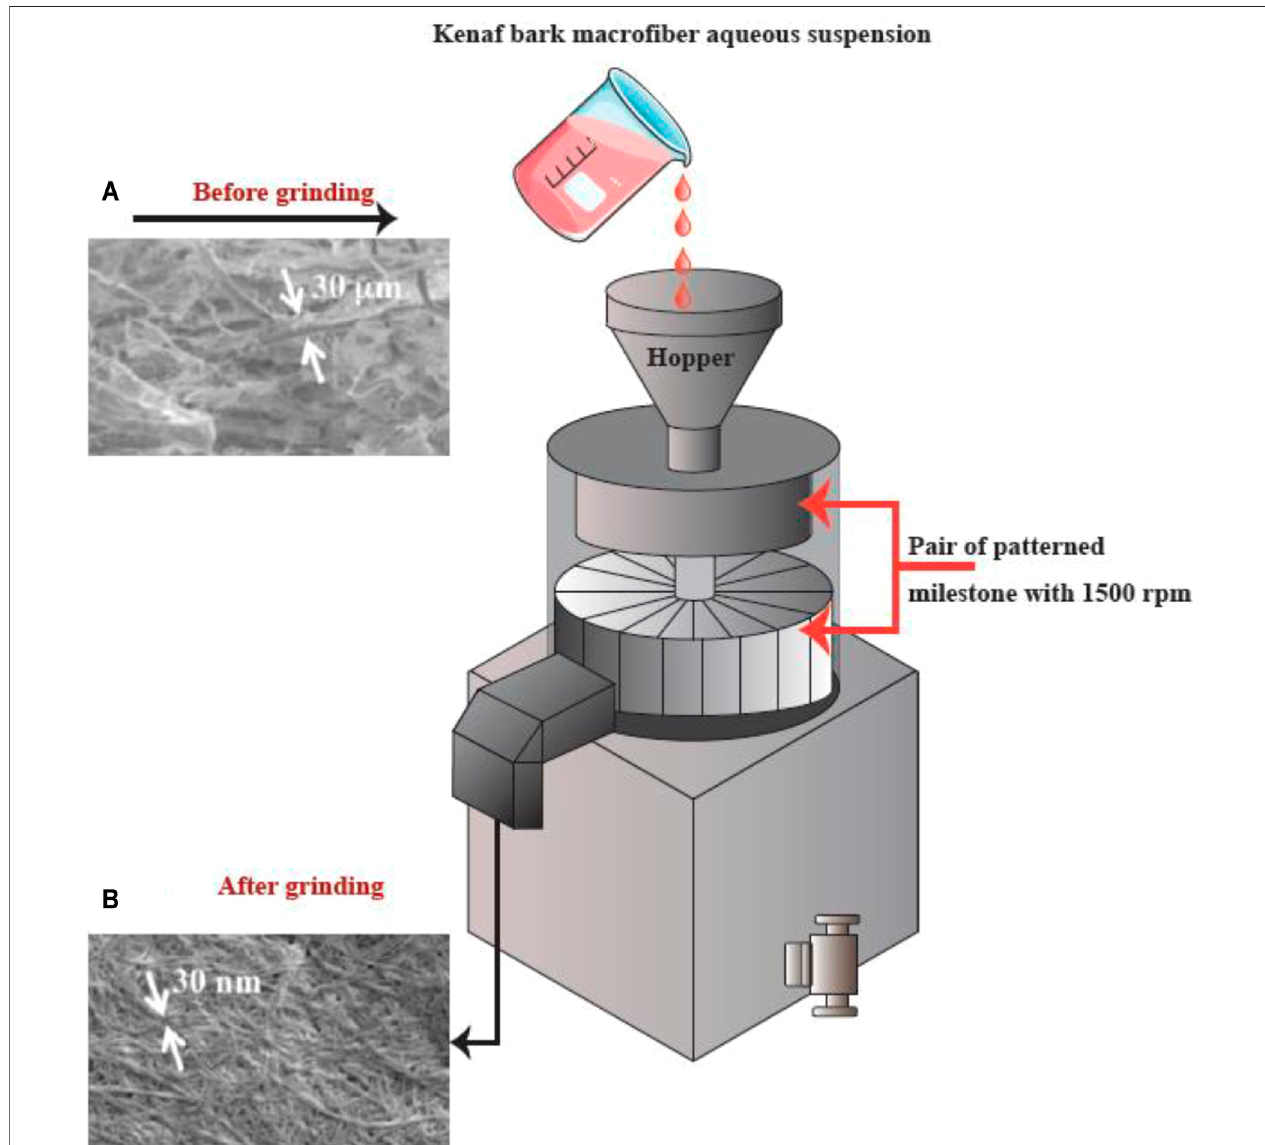
FIGURE 5 | The apparatus for the micro fl uidizer method, and SEM images of the fi bers after treatment. This fi gure adapted from Nishino et al. (Nishino 2017).